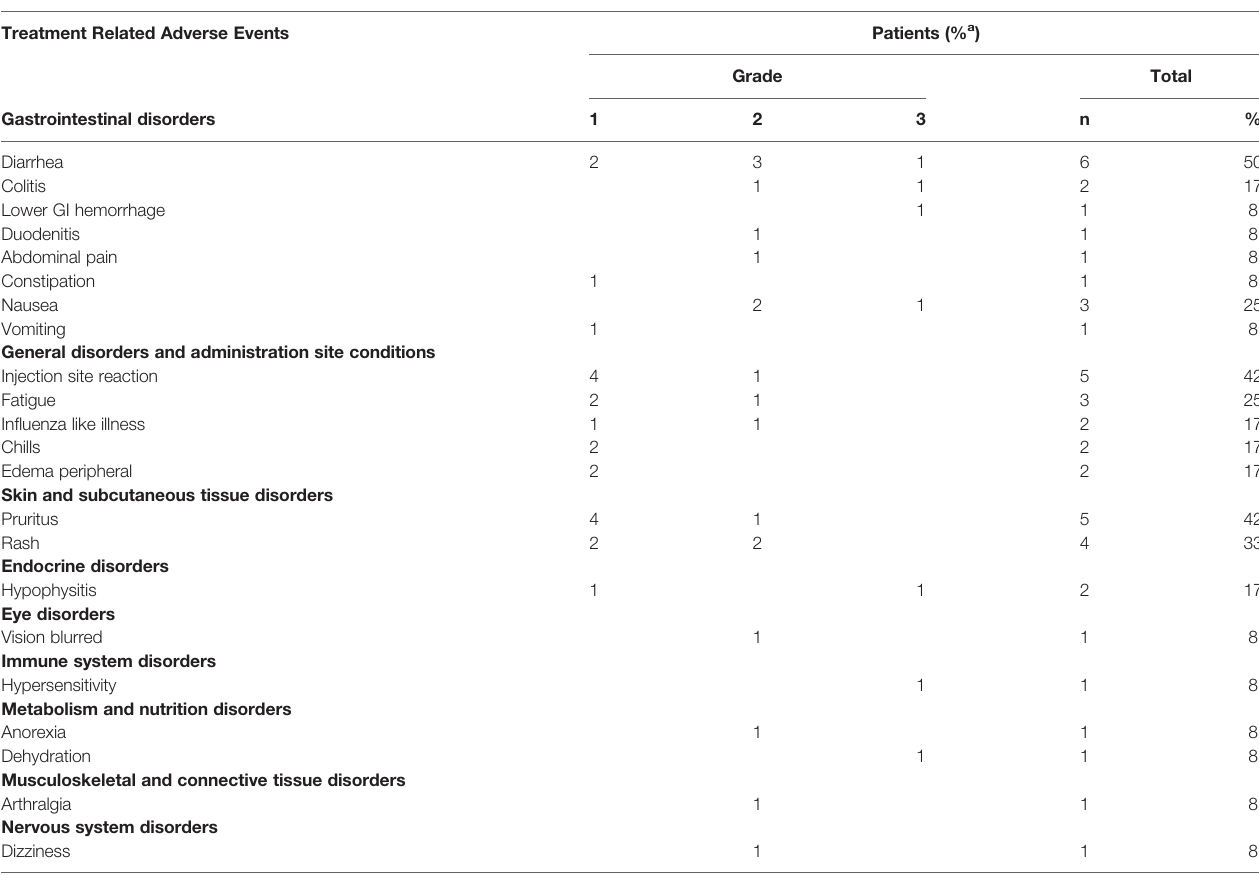
TABLE 2 | Treatment related adverse events in the safety population. Treatment Related Adverse Events